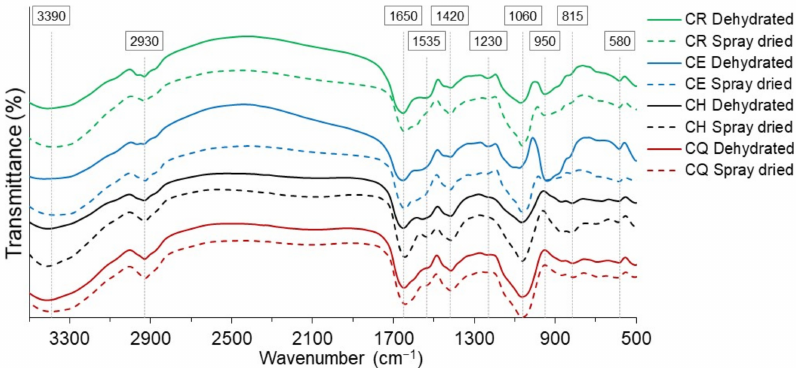
Figure 3. IR spectra for dehydrated and spray-dried